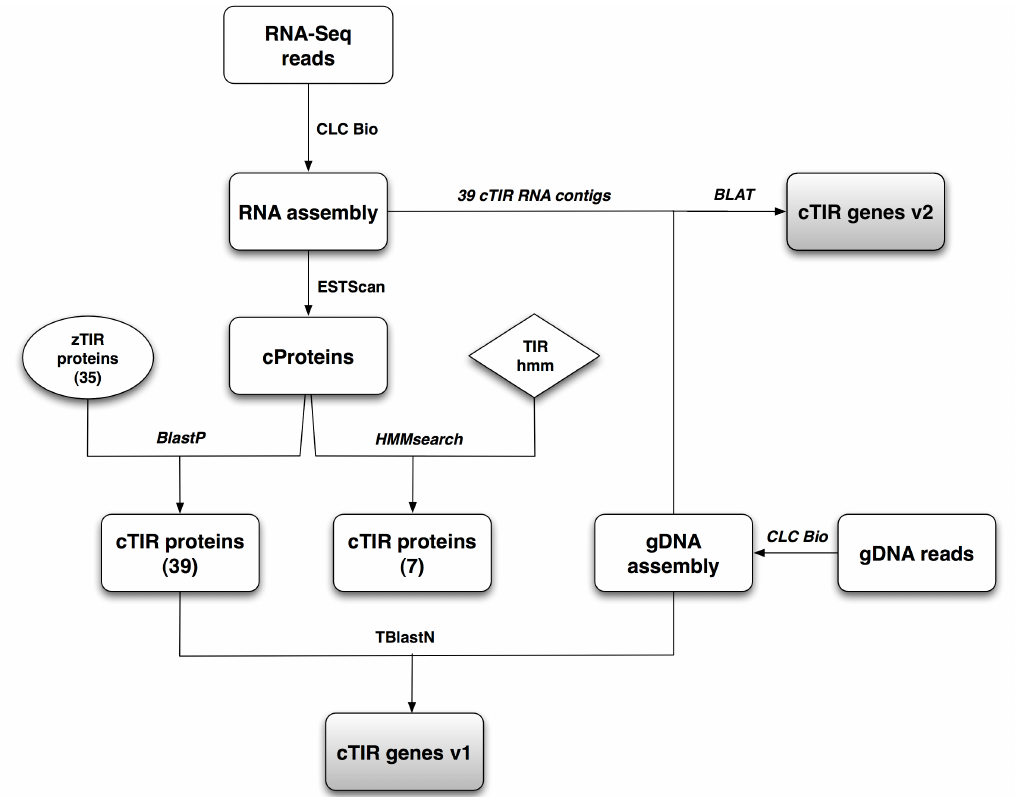
Figure 2: TIR containing gene annotation pipeline. Two version of carp TIR gene sequences (abbreviated as cTIR genes v1 and cTIR genes v2) derived from different methods are compared and further integrated to construct the final TIR